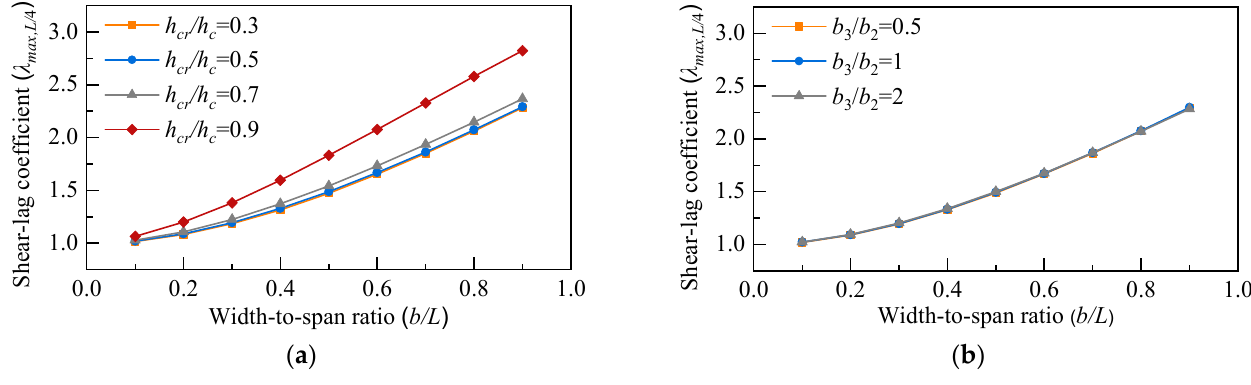
Figure 15. Relation curve of b/L and λ max,L /4 : ( a ) different h cr /h c ( b ) different b 3 / b 2.